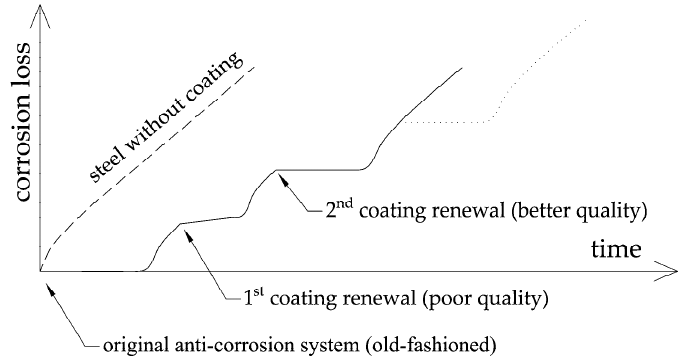
Figure 10. Possible time-corrosion loss relationship in the case of old bridge structure.